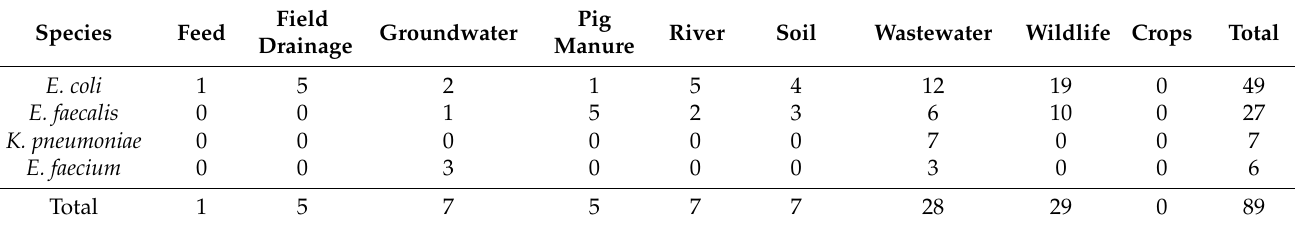
Table 1. Number of isolates gathered by species and compartment in Petzenkirchen, Austria,